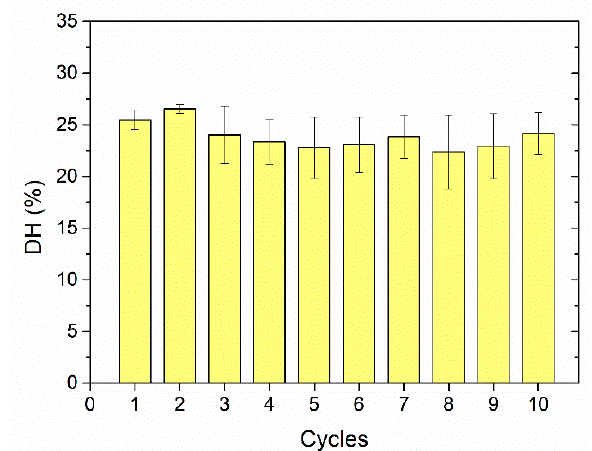
Figure 11. Profile of hydrolysis of casein (26 g/L) at 50 °C, pH 6.5 and 500 rpm stirring catalyzed by free and immobilized NPD (AgGly-NPD loaded with 18.9 mg protein/g support) using an enzyme concentration in the reactor of ( A ) 0.08 g/L and ( B ) 0.26 g/L.